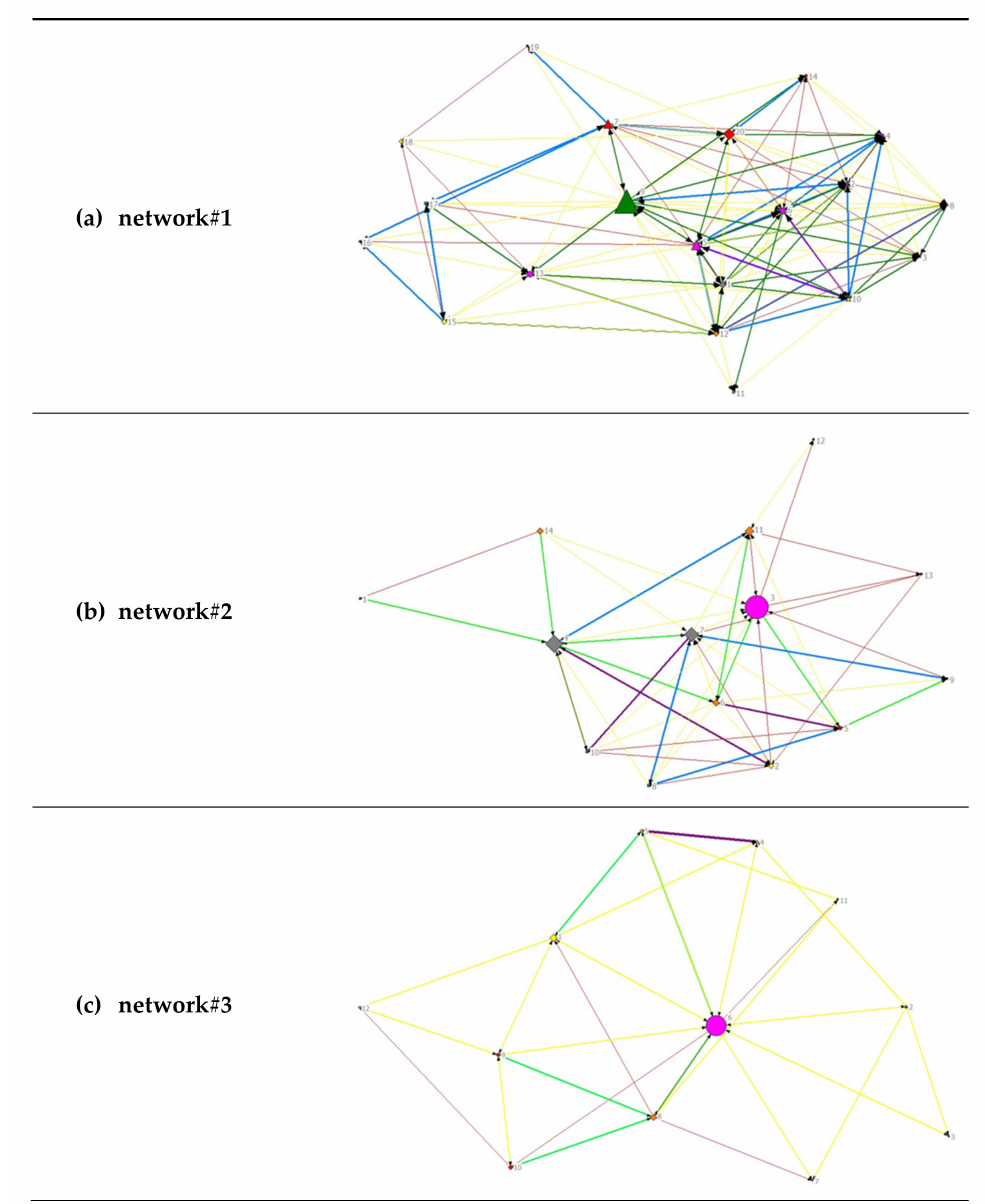
Figure 5. Visualization of network data regarding frequency of contacts separately for ( a ) network#1, ( b ) network#2 and ( c ) network#3. Node size by betweenness. Frequency of contact: no color, no contact; red, 1 × /year; yellow, 1 × /quarter; green, 1 × /month; blue, 1 × /week; purple, 1 ×